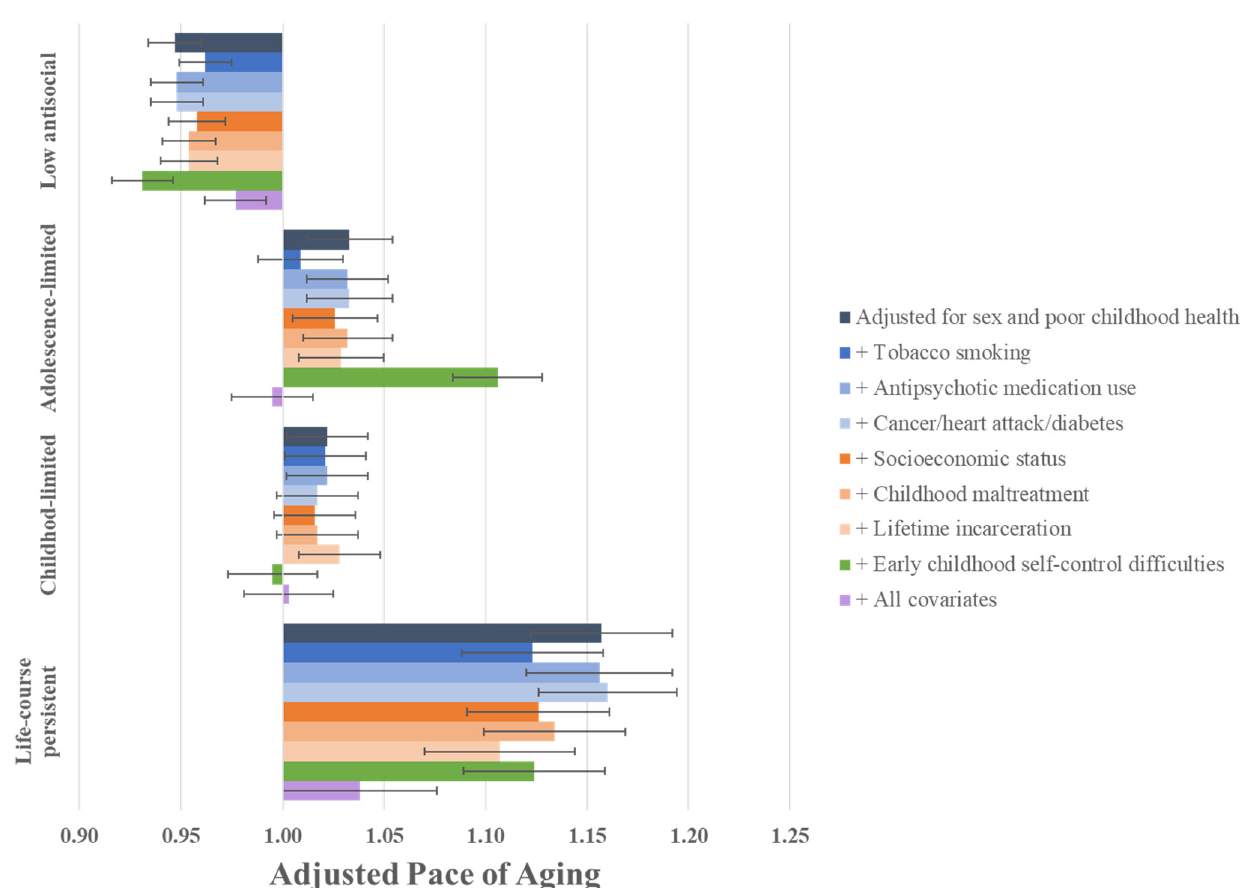
Figure 2. Association between antisocial behavior trajectories and Pace of Aging at midlife, control- ling for the 7 study covariates shown in colors (n = 934). The figure compares life-course persistent, childhood-limited, and adolescence-limited antisocial groups to a reference group of study members who engaged in no or low levels of antisocial behavior. Figure shows adjusted means and standard errors for one outcome (Pace of Aging); Supplemental Tables S1–S3 provide the results for all of the other aging outcomes.